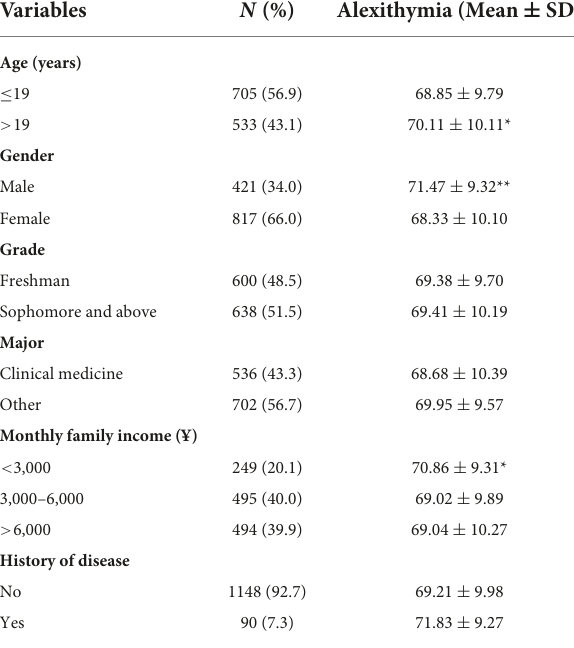
TABLE 1 Demographic characteristics and distributions of alexithymia among medical students ( N = 1,238).